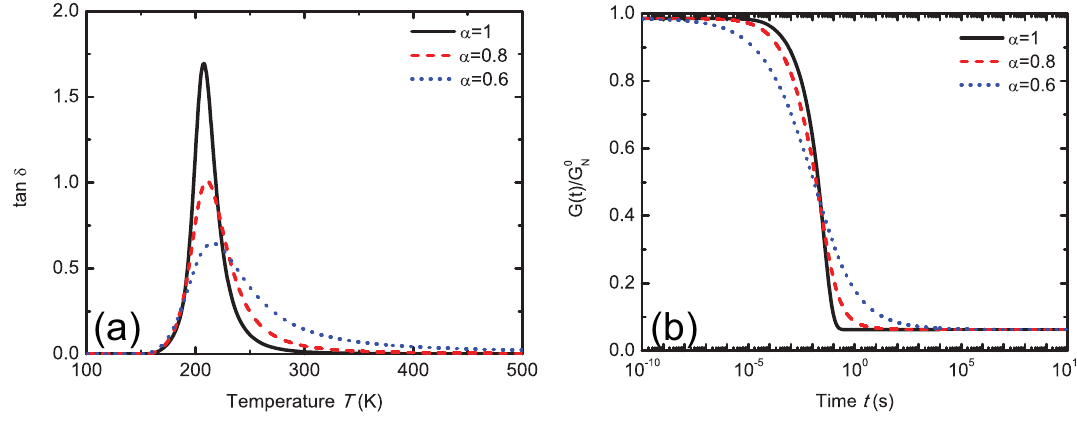
Figure 25. Effect of the Mittag-Leffler exponent, α , on ( a ) tan δ and ( b ) the relaxation modulus, G ( t )